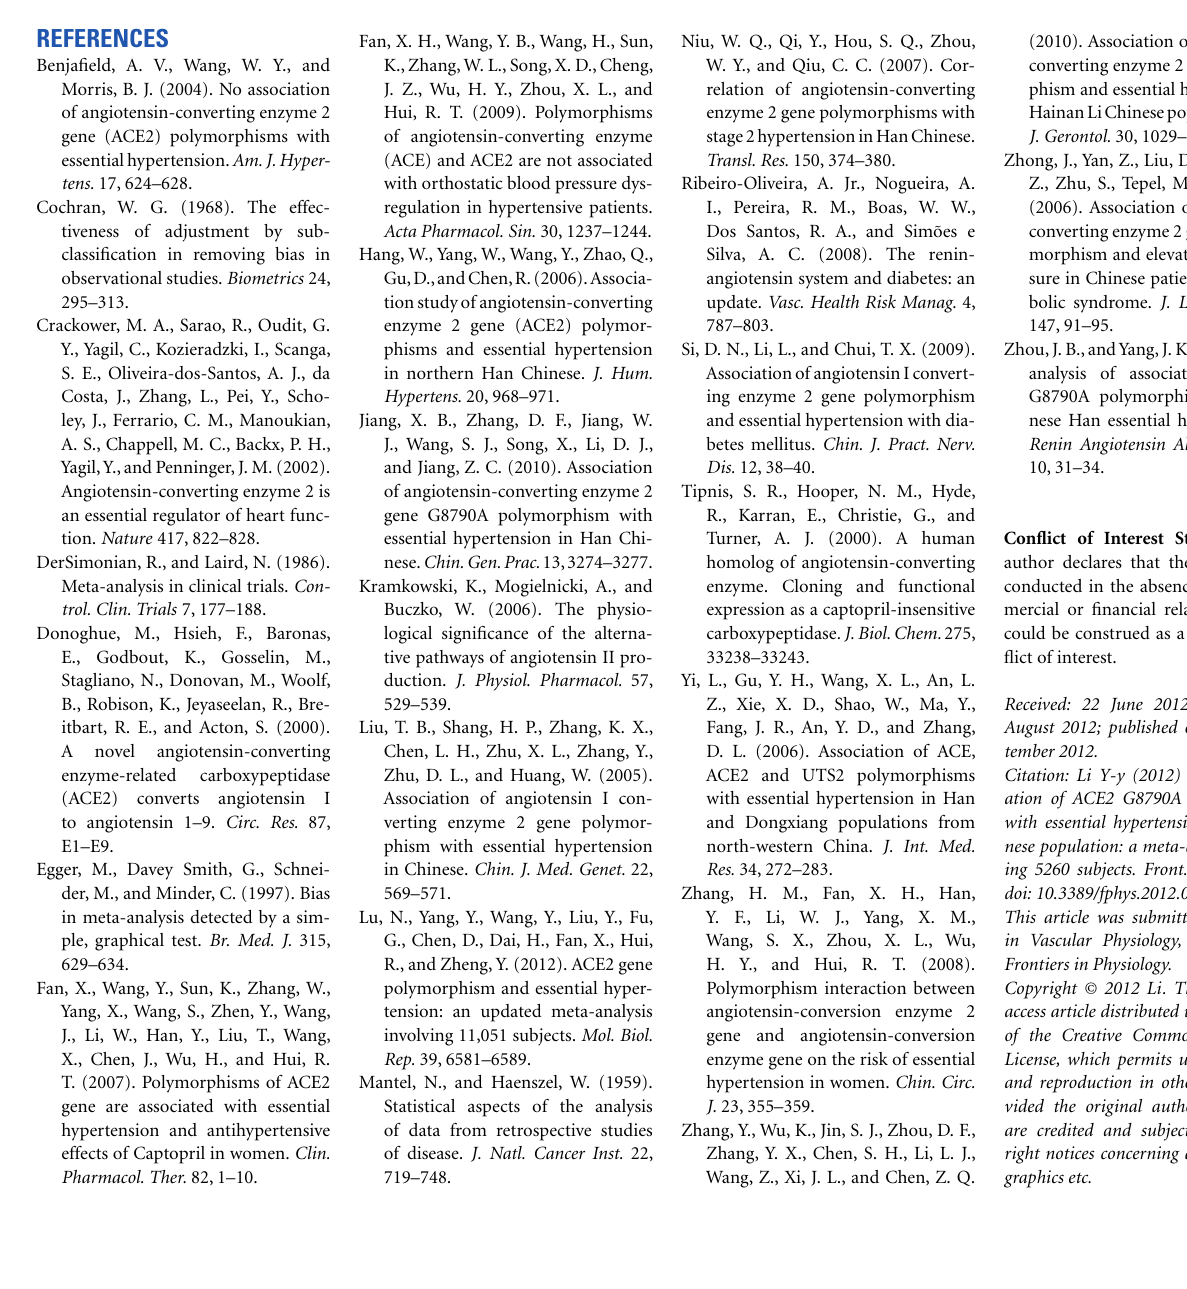
Table S1 | Characteristics of the investigated studies of the association between theACE2 G8790A gene polymorphism and EH of the male subgroup. Table S2 | RT-PCR primers utilized for each gene in the RT-PCR